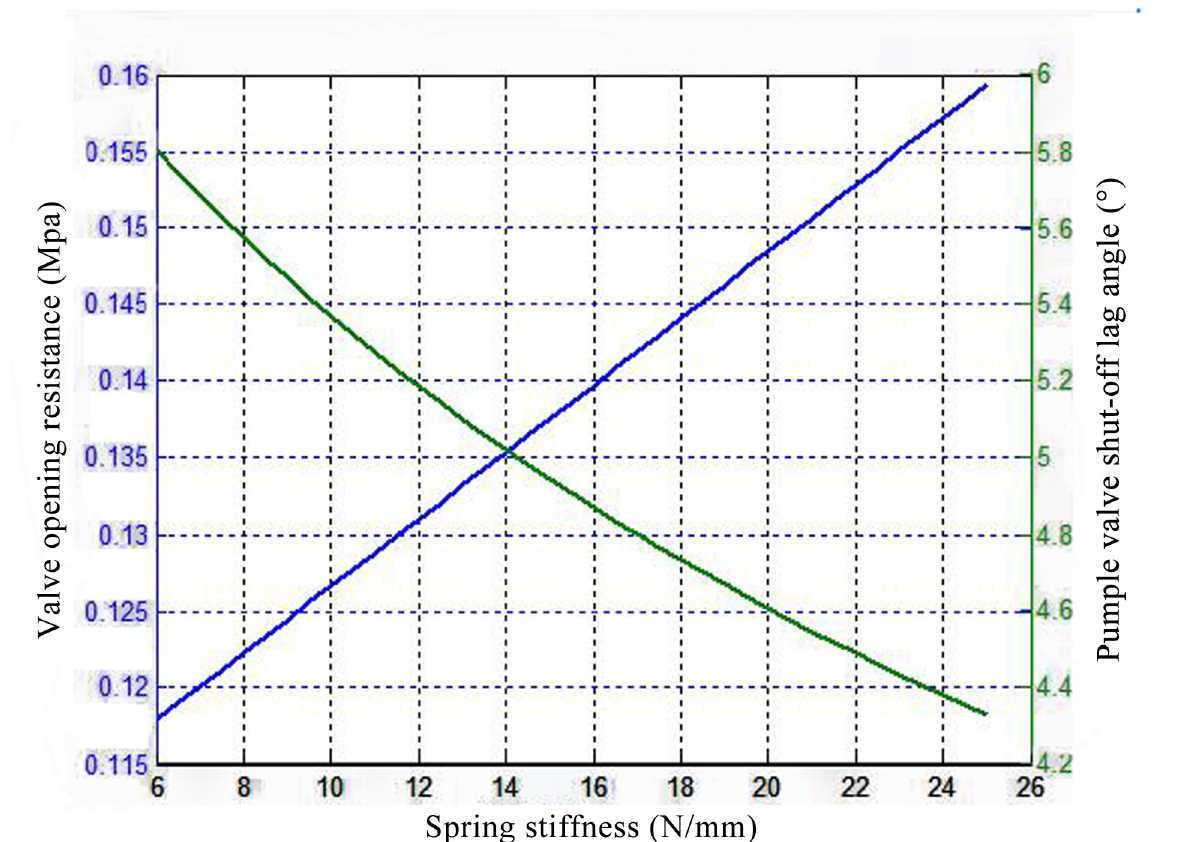
Fig 15. Curve of valve opening resistance and shut-off lag angle with respect to spring stiffness.